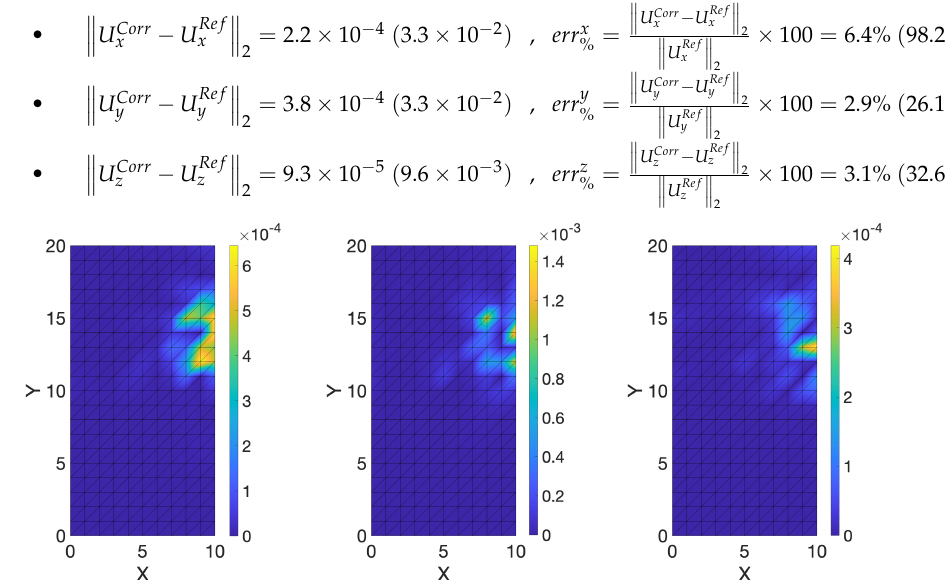
Figure 5. Top view of the difference in absolute value between the corrected and the reference displacement field, for x ( left ), y ( middle ) and z ( right ) components.